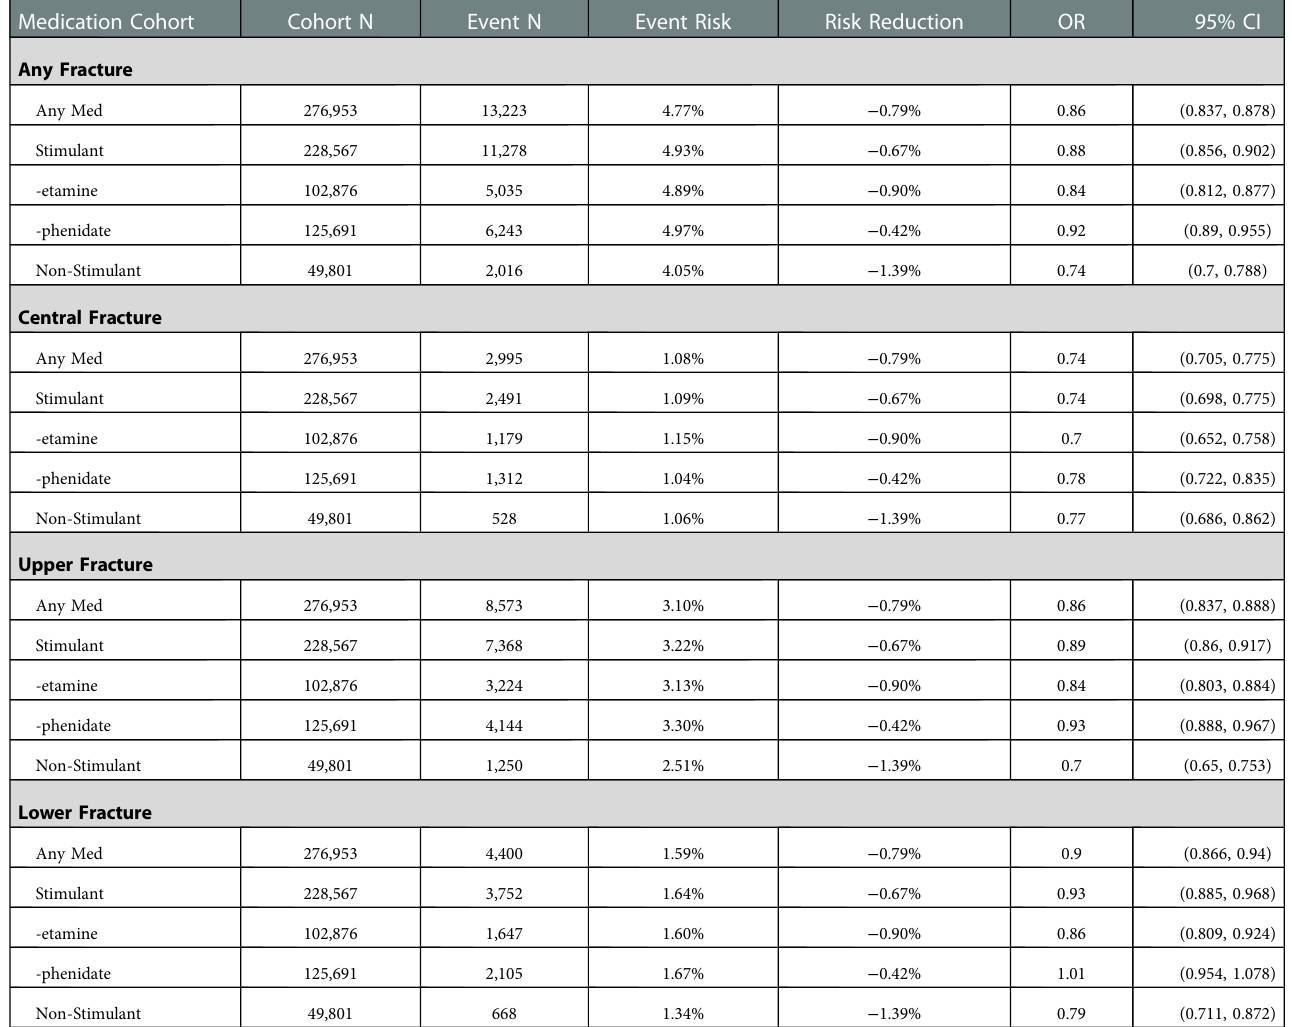
TABLE 1 Cohort size, absolute risk, odds ratio, and t test p -value by outcome (ICD-10). Medication